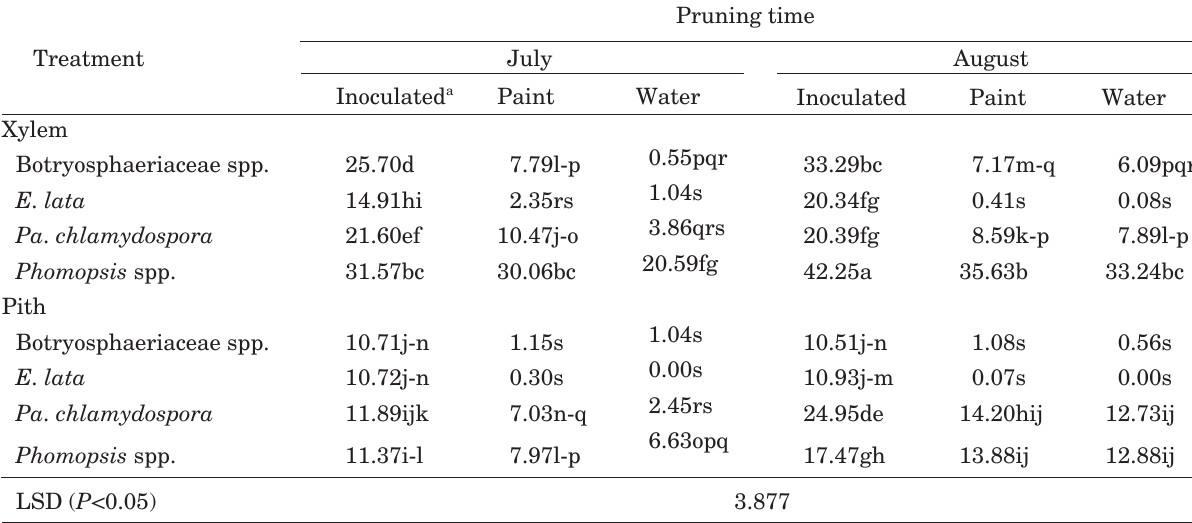
Table 3. Mean incidence of Eutypa lata , Phaeomoniella chlamydospora , Botryosphaeriaceae and Phomopsis spp. in the xylem and pith tissues of pruning wounds that were made during July and August 2004 and 2005 and either painted, water treated or inoculated with Eutypa lata , Phaeomoniella chlamydospora , Neofusicoccum australe and Phomopsis viticola directly after pruning, 1, 2, 3, 7, 10, 14, 17 and 21 days after pruning.